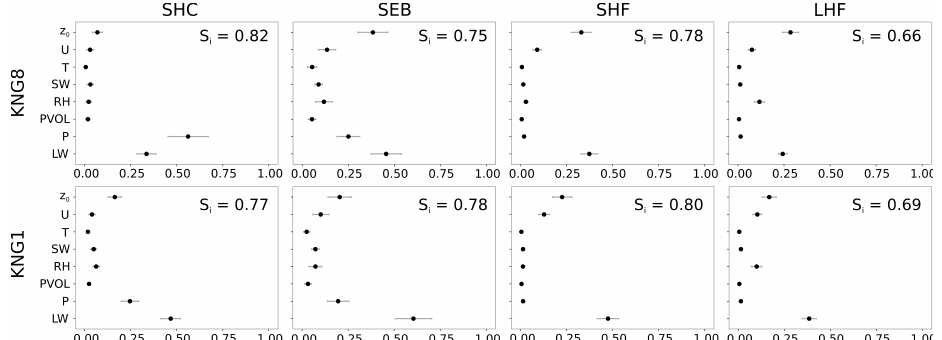
Figure 4. Yearly averaged total-order effects of factors (see Table 2) on surface-height change (SHC), surface-energy balance (SEB) and sensible heat flux (SHF) and latent heat flux (LHF) at KNG8 and KNG1. The whiskers show the 95% confidence interval derived from 1000 empirical bootstrap samples. The mean (taken over the whole period) of the 6-hourly first-order sums (linear effects) are given in the upper right